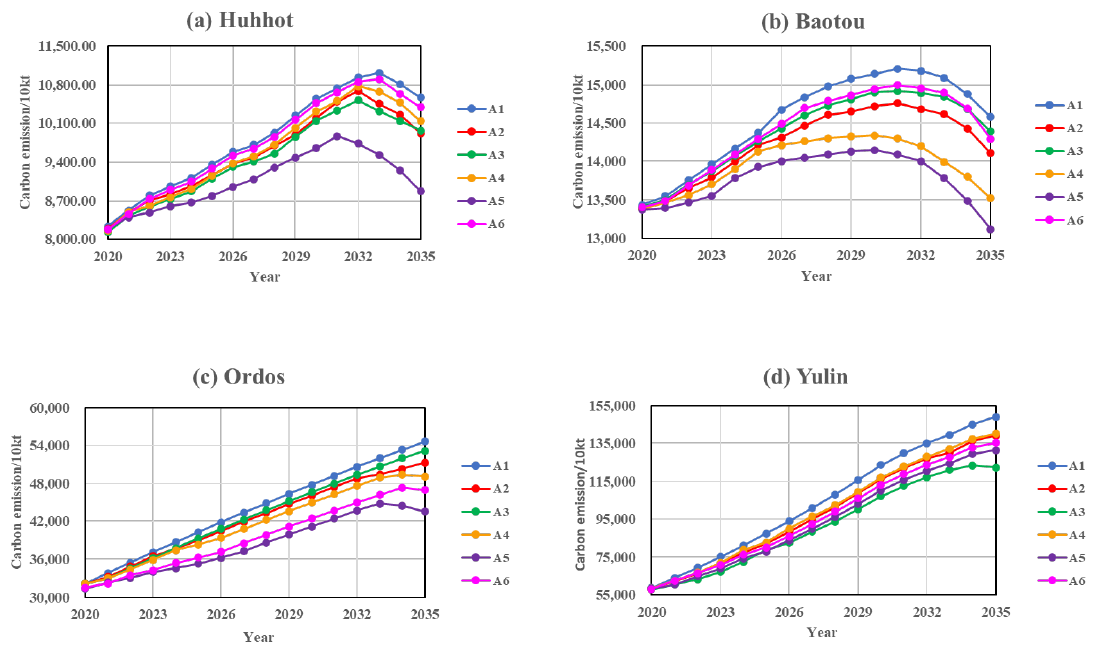
Figure 5. Projections of urban carbon emissions under the single regulation scenario. (1) Baseline Scenario (A1)